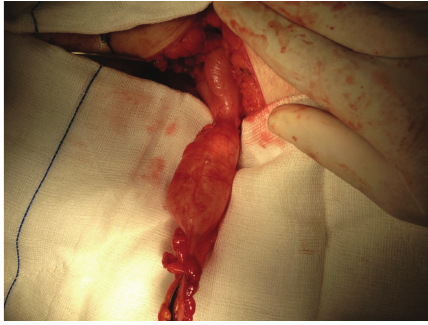
Figure 1: Intraoperative view of mucocele of the appendix.